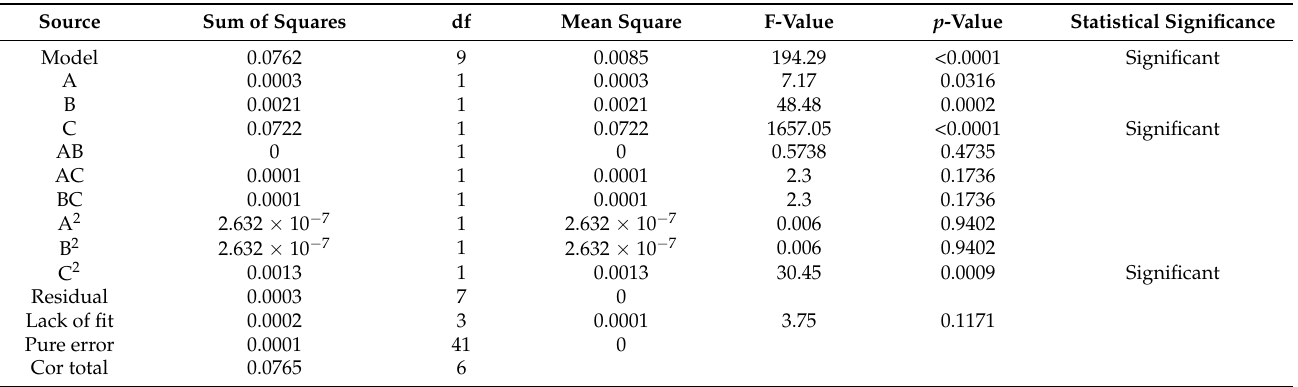
Table 4. Response surface significance